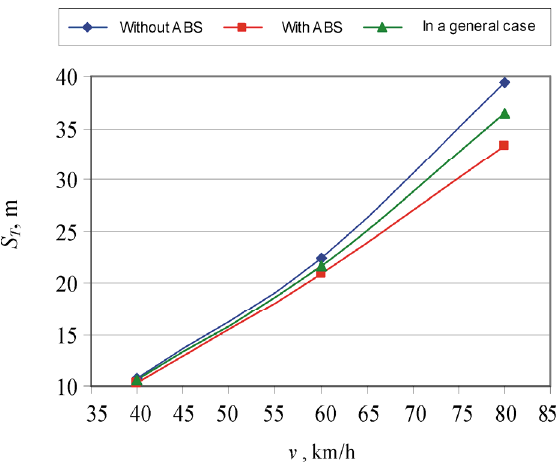
Fig 7. The dependence of braking distance on the initial speed of movement of the